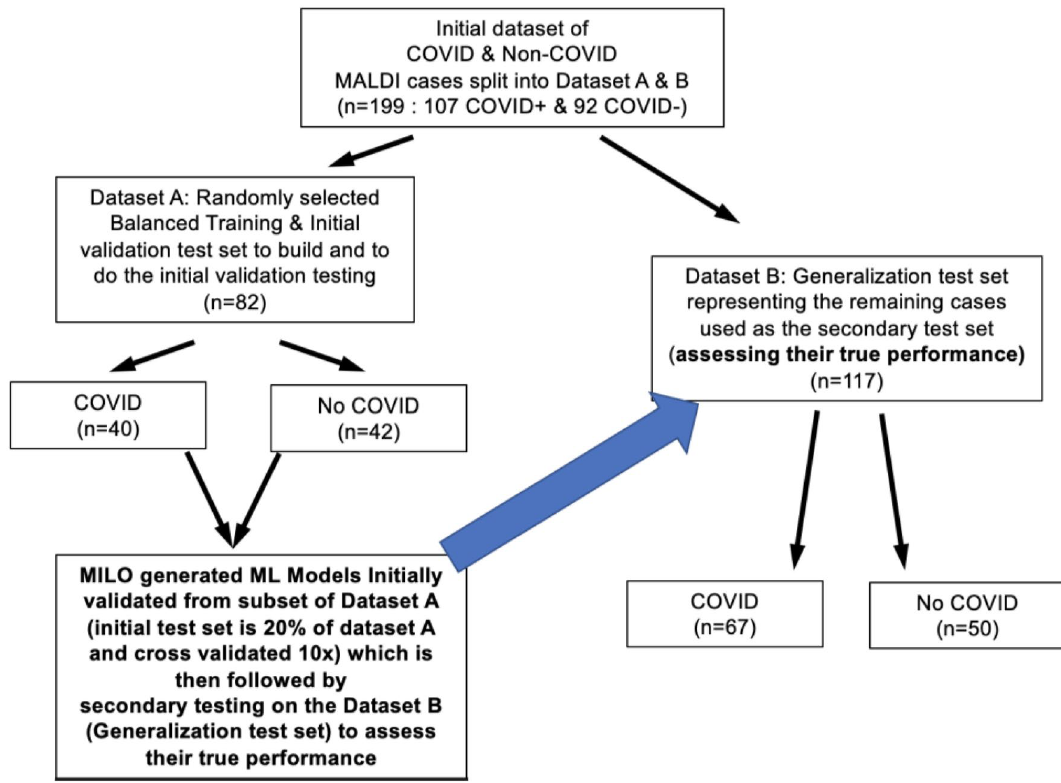
Figure 3. Study datasets. A total of 226 asymptomatic and symptomatic patients were enrolled. Twenty-seven samples were invalid due to polymer contamination, preventing MALDI-TOF-MS analysis. The remaining 199 were successfully tested by MALDI-TOF-MS and produced spectra. These data were divided into Datasets A and B, with Dataset A serving as the training/initial validation dataset. Optimized models produced from Dataset A were then secondarily tested with Dataset B for generalization to assess their true